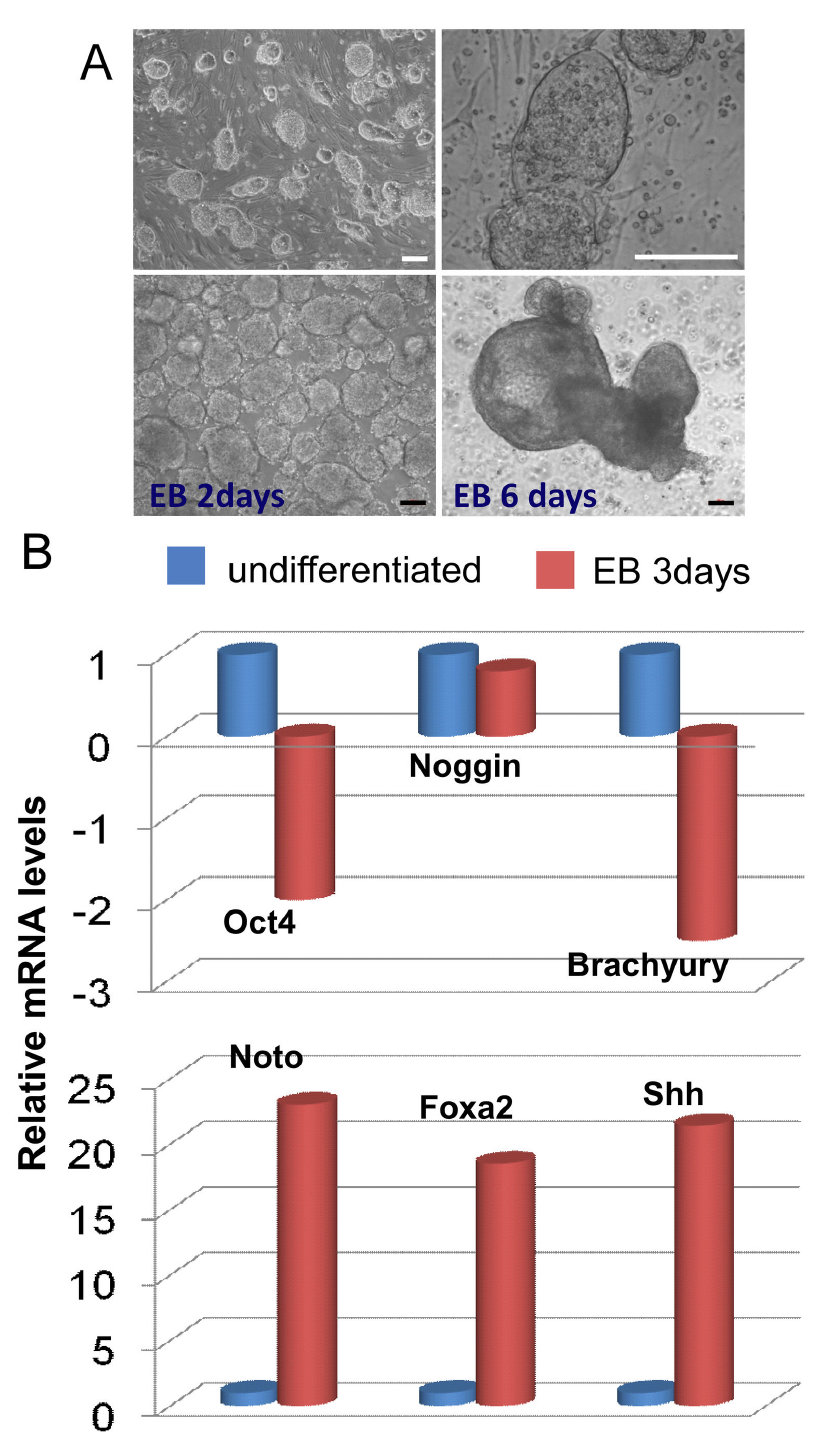
Figure 1. iPSC morphology and the expression notochordal-related transcriptional factors. (A) Undifferentiated iPSCs cultured on a feeder layer of mitotically inactivated mouse embryonic fibroblasts and formed colonies (top panels); iPSCs formed cell clusters of embryoid bodies (EBs, bottom panels) when promoted to undergo spontaneous differentiation in ultra-low attaching dishes (bars = 100 µm). (B) Relative mRNA levels for transcriptional factors ( Oct4, Noggin, Brachyury, Noto, Foxa2, Shh ) in EBs (3 days) normalized to undifferentiated iPSCs for each target gene. Data are averages of two replicates for cells collected from multiple EBs and undifferentiated culture. doi: 10.1371/journal.pone.0075548.g001 PLOS ONE |